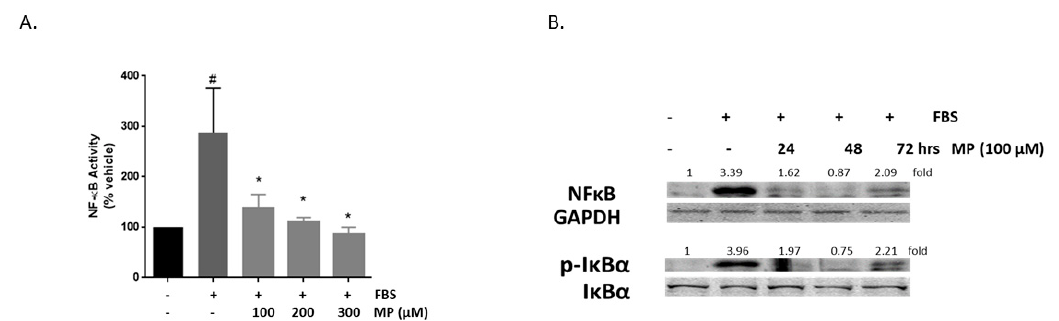
Figure 11. MP inhibits FBS-induced NF- κ B expression in a time- and concentration-dependent manner, and attenuates the activation of its inhibitor, I κ B α . ( A ) Cells were treated with FBS in the absence or presence of increasing concentrations of MP (100, 200, and 300 µ M). NF- κ B expression was determined by luciferase assay. Values represented are mean ± SEM. # denotes p < 0.05 (FBS versus vehicle) and * denotes p < 0.05 (MP + FBS vs FBS)). ( B ) Cells were treated with FBS in the presence or absence of MP (100 µ M) for 24, 48, and 72 h. Expression of NF- κ B and phosphorylation of IKB α were detected by Western blotting. Values mean fold change of three independent experiments. One-way ANOVA followed by Tukey’s test was performed.